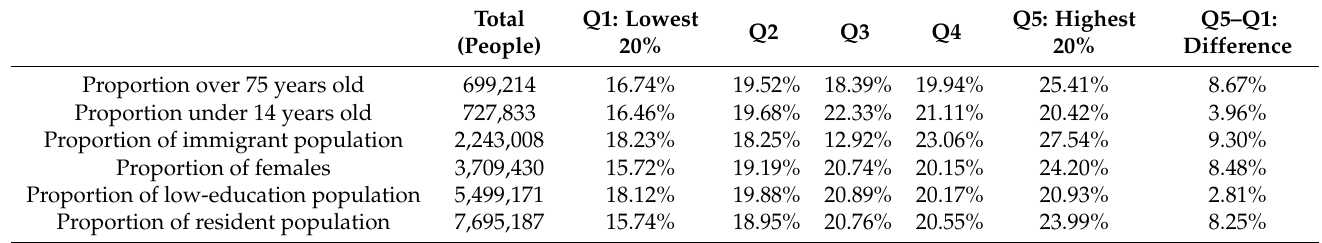
Table 2. Distribution differences of six categories of vulnerable groups for the flooded proportion in Nanjing.